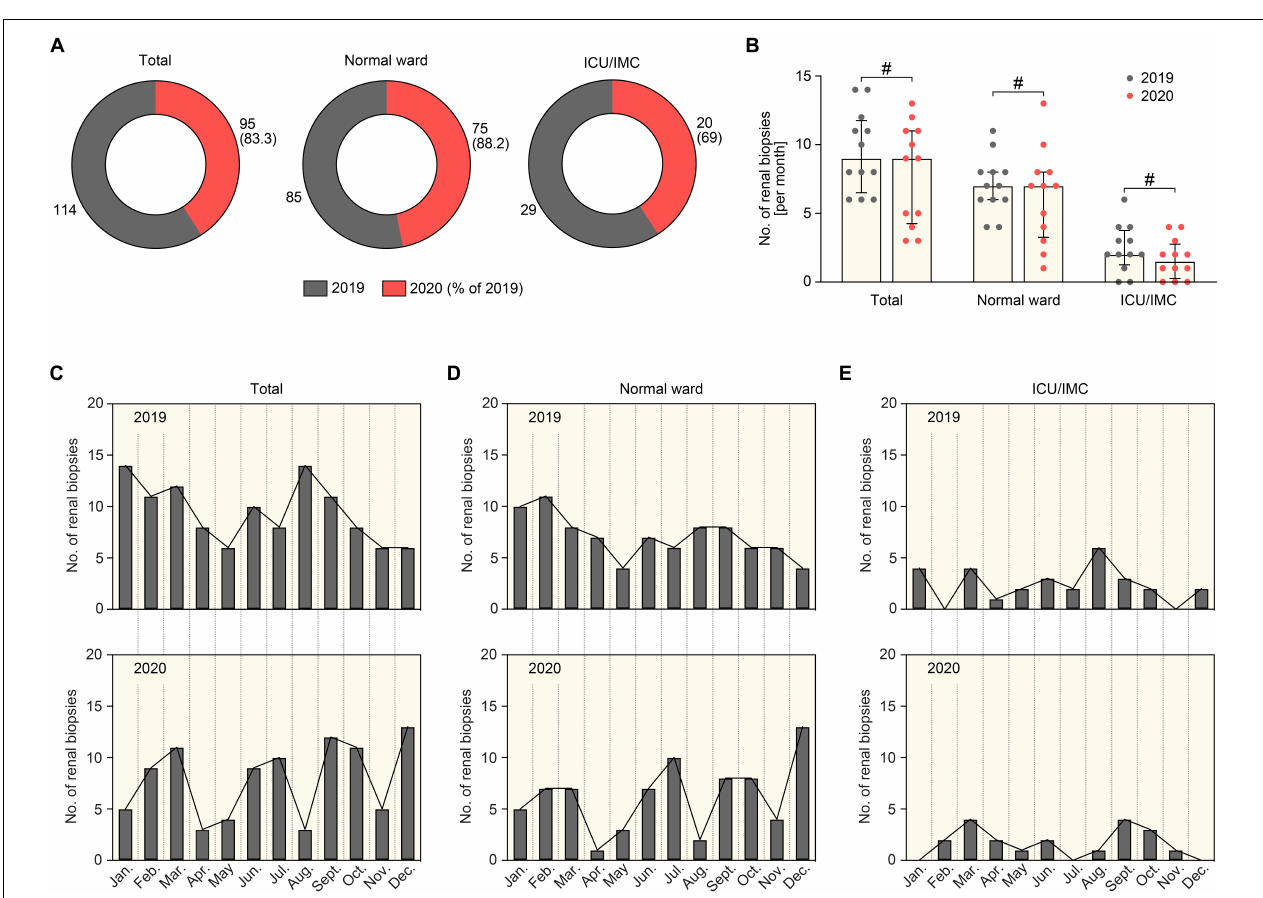
FIGURE 2 | Comparison of renal biopsies performed in 2019 and 2020 during the COVID-19 pandemic. (A) Total number of renal biopsies in 2019 and 2020 in total patients, patients admitted to the normal or ICU/IMC medical ward. (B) The scatter dot plots represent medians and IQR with individual data points summarizing the number of renal biopsies per month in 2019 compared to 2020, the Mann-Whitney U -test was used to determine differences in medians and # indicates no statistic significance. (C–E) Absolute number of renal biopsies per month in 2019 and 2020 in total patients, patients admitted to the normal or ICU/IMC medical ward. Apr., April; Aug., August; Dec., December; Feb., February; ICU, intensive care unit; IMC, intermediate care unit; Jan., January; Jul., July; Jun., June; Mar., March; No., number; Nov., November; Oct., October; Sept., September.